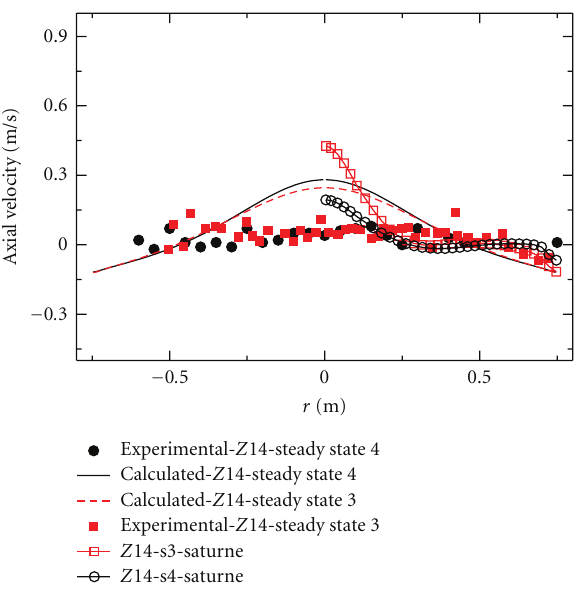
Figure 15: Radial profile of the vertical gas velocity at Z 14 = 4m: steady state 3 and 4.